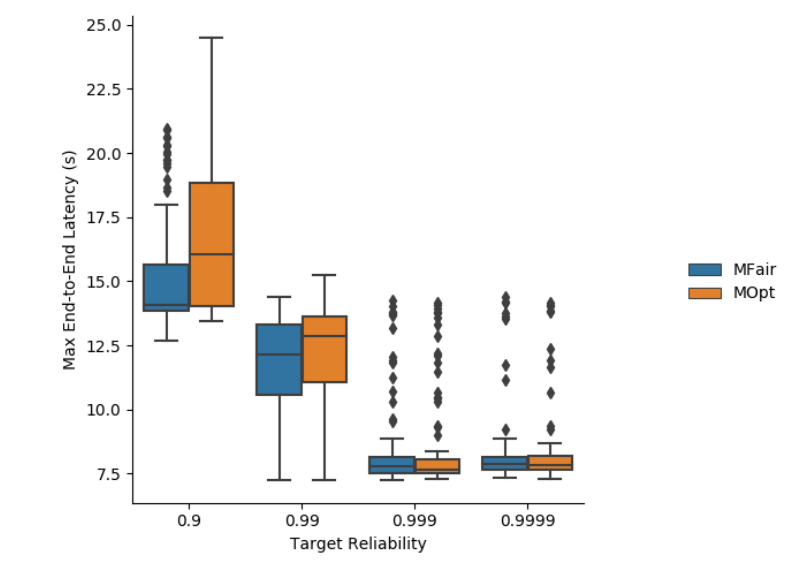
Figure 11. Maximum end-to-end latency obtained by simulation with MFair and MOpt